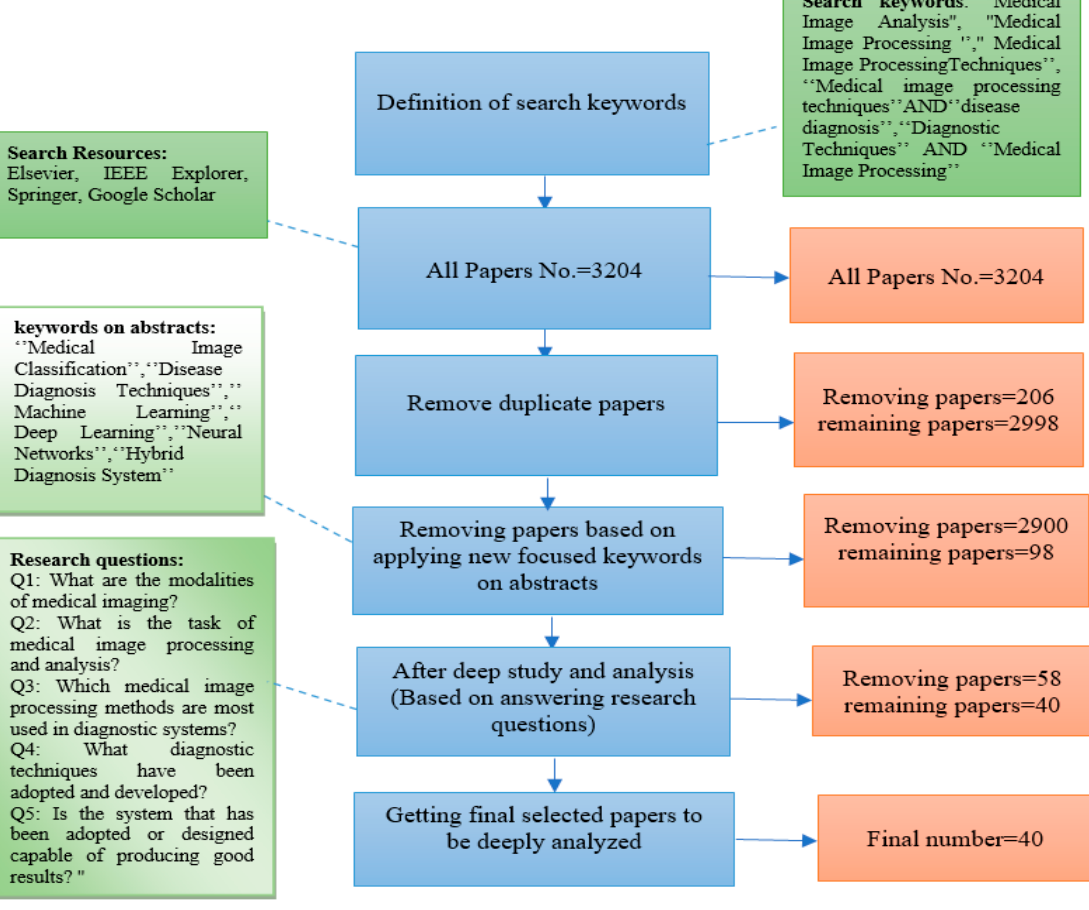
Figure 1. Flowchart of the process for article